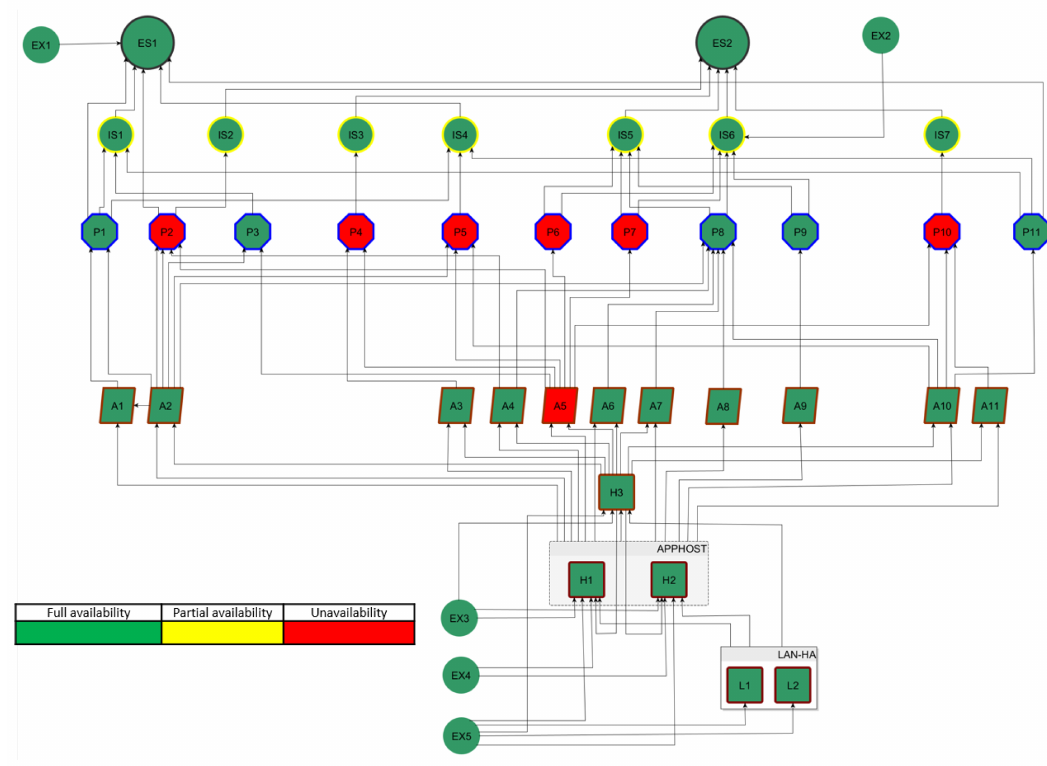
Figure 9. Objects availability at time t = 15 s.